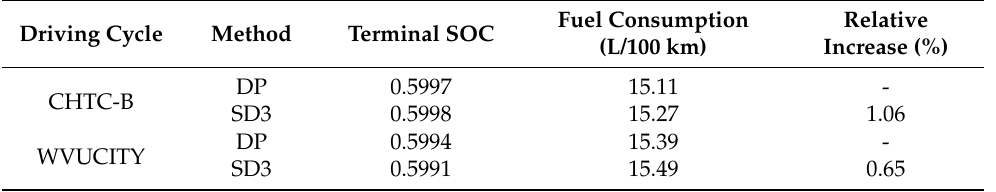
Table 4. Fuel consumption in simulation of initial SOC = 0.6.